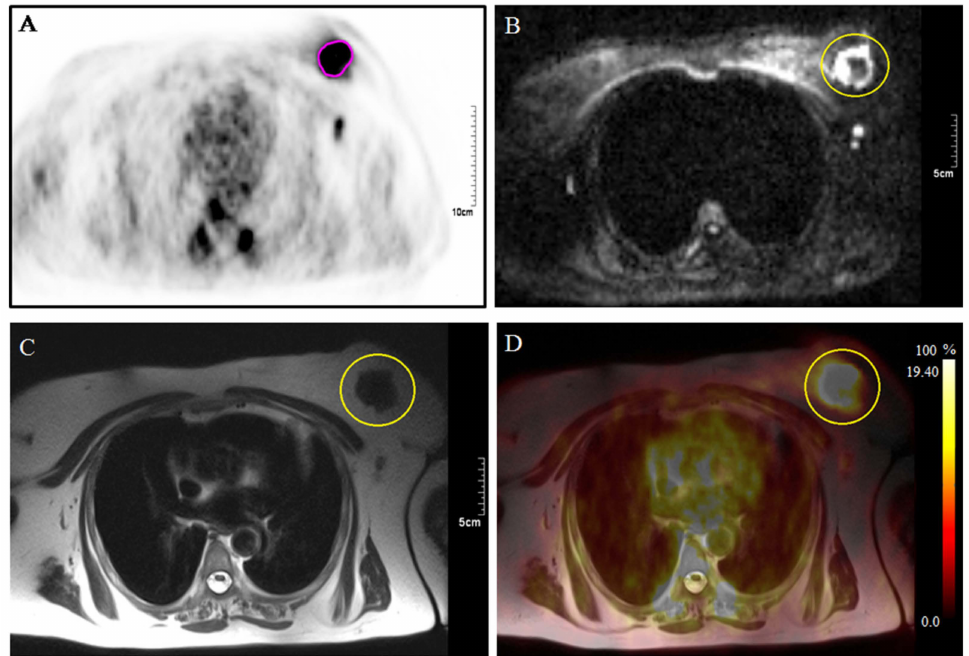
Figure 2. 18 F-FDG-PET / MRI scan Images of a 57-year-old patient with a breast heteroplasia with lymph node and bone metastases. The yellow circle indicates the lesion located on the left breast: ( A ) PET image showing uptake after 60 minutes of a segmented lesion (pink depicted); ( B ) Lesion revealed on T2 weighted image acquired on the axial plane; ( C ) hyperintensity of the lesion on di ff usion-weighted magnetic resonance imaging; ( D ) 18 F-FDG-PET / MRI fusion